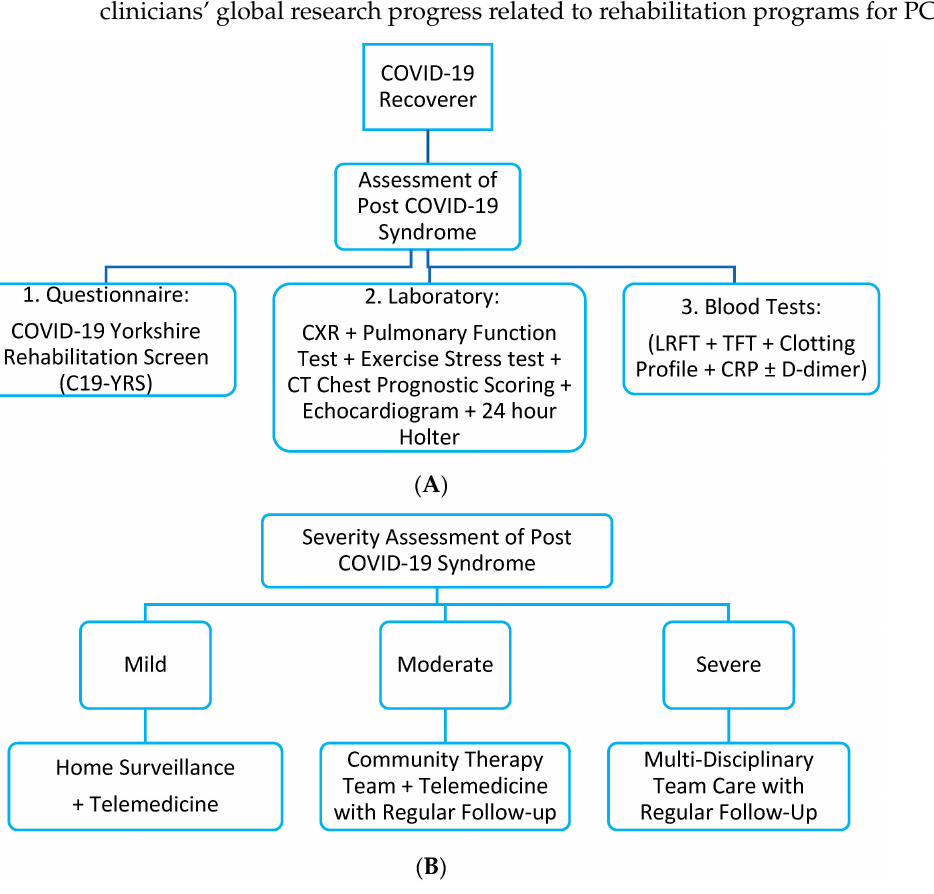
Figure 4. Recommended rehabilitation model for patients with Post-COVID-19 Syndrome [8], as previously suggested by other authors. However, the key point lies in the severity assessment of Post-COVID-19 Syndrome and its classification. The limitation with this classification system is that there has not been a unified classification system for clinical severity. ( A ) Basic screening assessment of Post-COVID-19 Syndrome with prognostic scoring. ( B ) Recommended rehabilitation model based on initial assessment. CXR: Chest X-Ray. LRFT: Liver Renal Function Test. CRP: C-Reactive Protein. CT: Computed